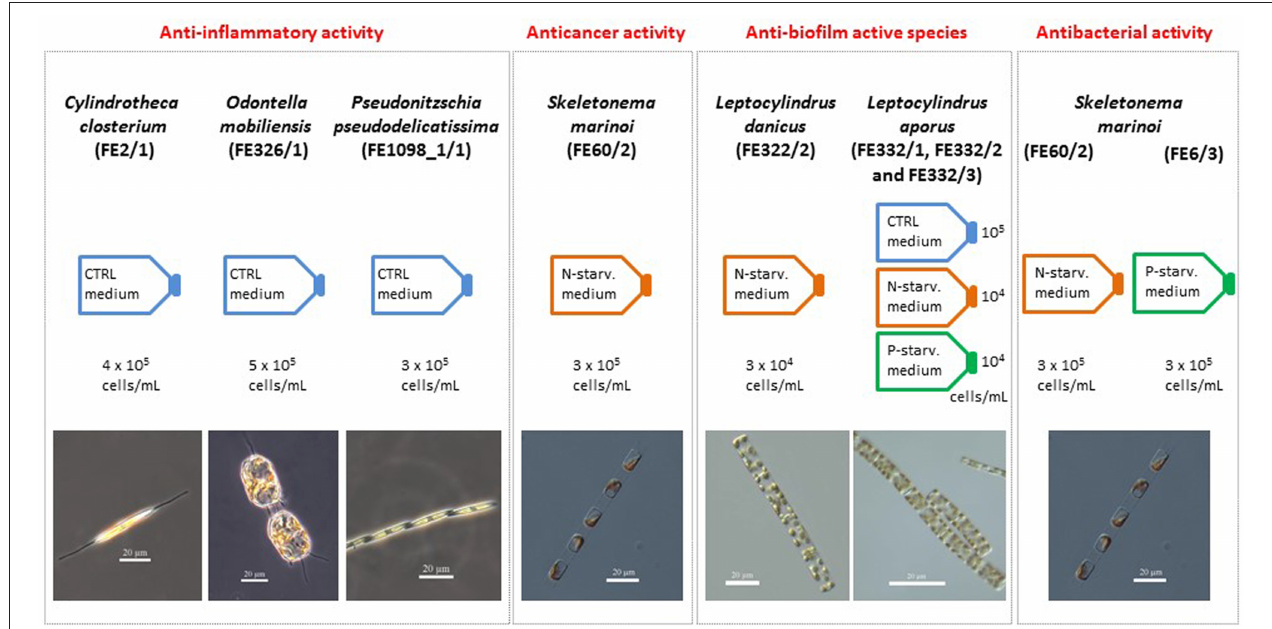
FIGURE 4 | Summary chart. Summary of the species and culturing conditions (CTRL, nitrogen- and phosphate-starved media, indicated with N- and P-starv. medium, respectively) that showed anti-inflammatory ( Cylindrotheca closterium FE2/1, Odontella mobiliensis FE326/1, Pseudonitzschia pseudodelicatissima FE1098_1/1), anticancer ( Skeletonema marinoi FE60/2), and anti-biofilm properties ( Leptocylindrus danicus FE322/2 and Leptocylindrus aporus FE332/1, FE332/2, and FE332/3). In addition, approximate cell concentration used for the preparation of the chemical extracts tested and species photos are reported.